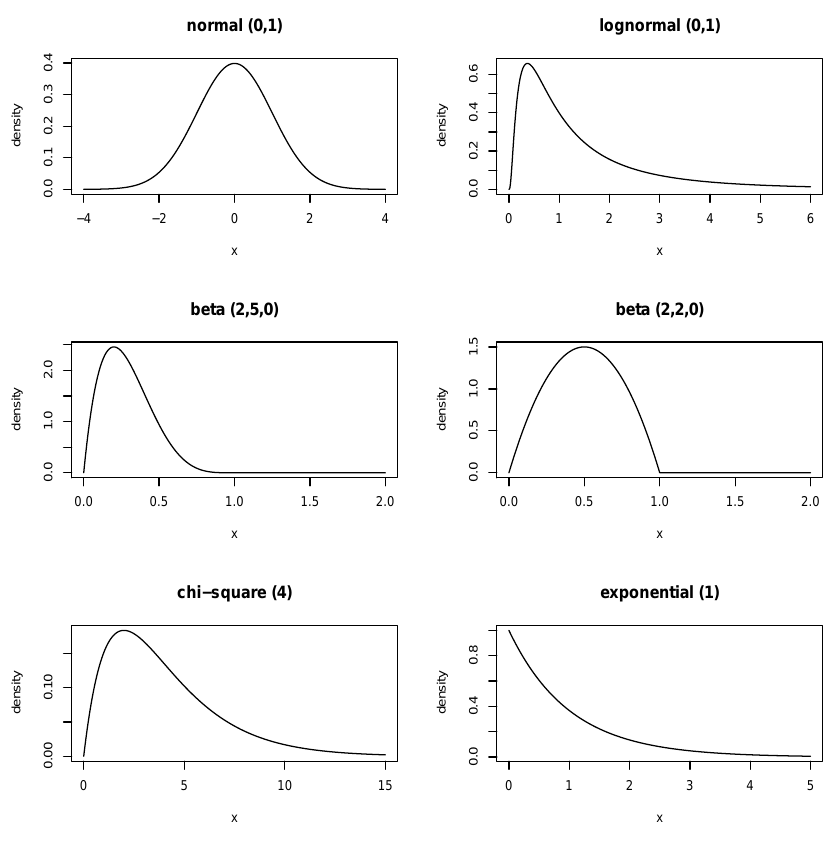
Figure 1. Density functions of the assumed